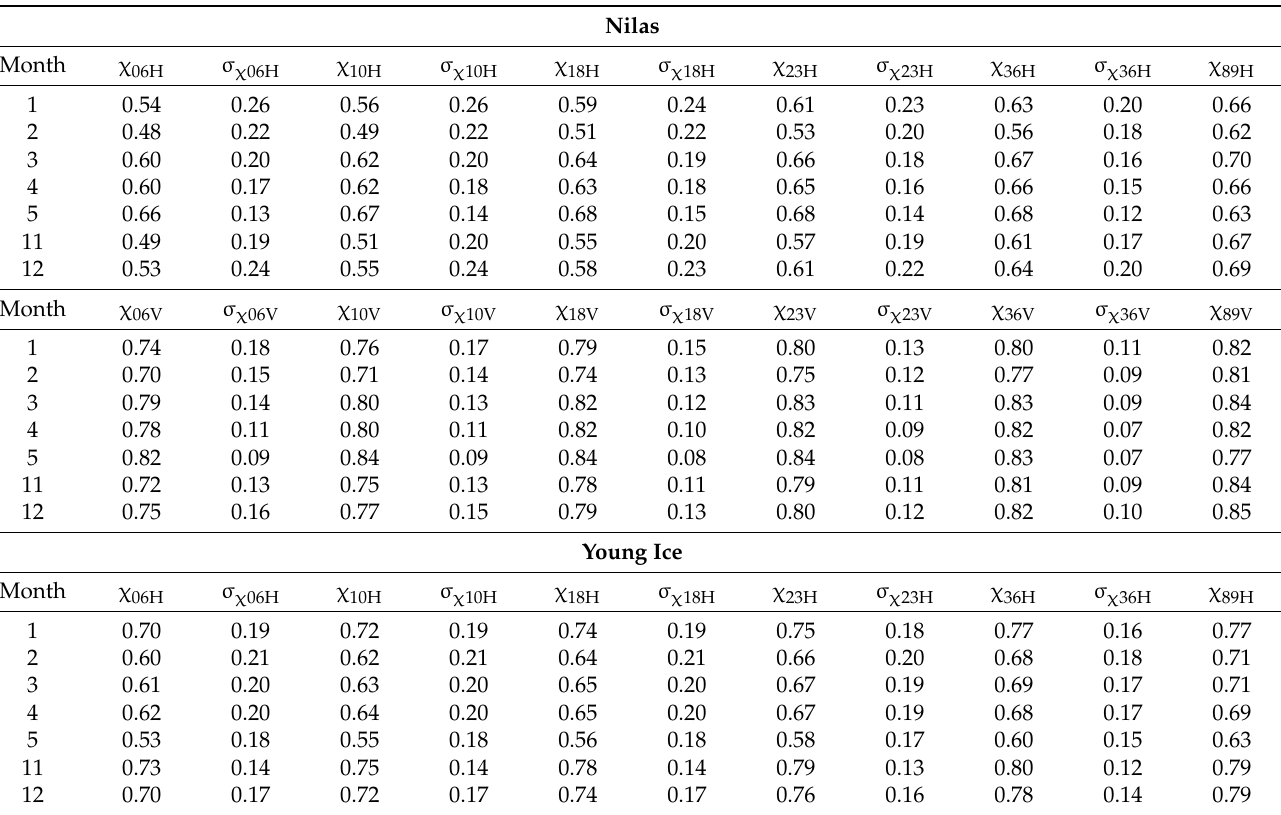
Table 1. Monthly averaged values of χ and σ χ , calculated for the χ subsets for every month at 6.9, 10.65, 18.7, 23.8, 36.5 and 89 GHz with H and V polarization (06H, 10H, 18H, 23H, 36H, 89H, 06V, 10V, 18V, 23V, 36V, 89V correspondingly) for the six sea ice types.